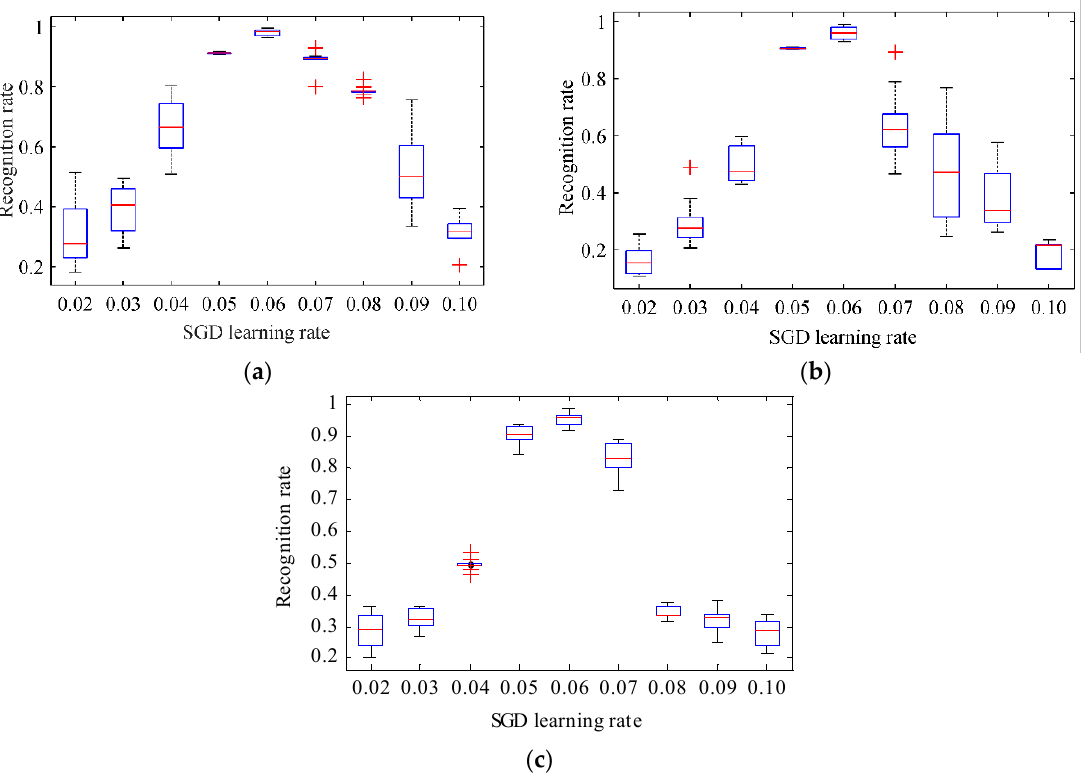
Figure 9. Boxplot of the recognition rate obtained by MCNN-DS under different SGD learning rates. ( a ) MNIST dataset; ( b ) EnglishHand dataset; ( c ) HCL2000 dataset.